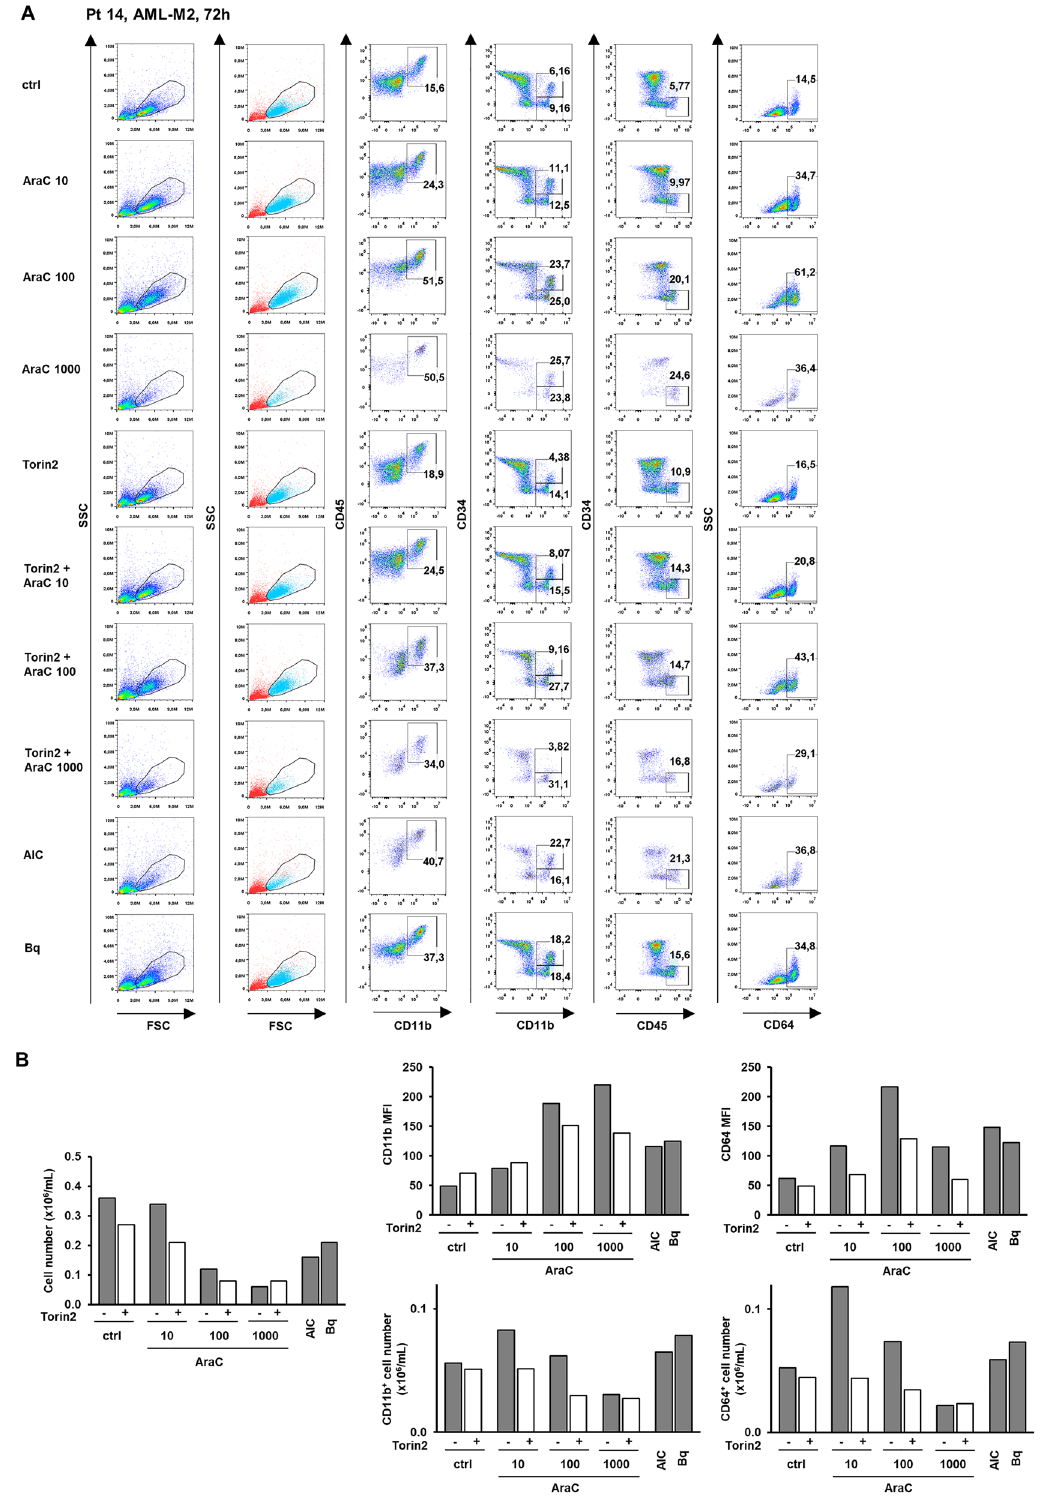
Figure 7. Cytarabine dose-dependently increases expression of differentiation markers in a primary sample from AML-M2 patient that was responsive to pyrimidine synthesis inhibition. Non-adherent mononuclear cells from bone marrow sample (Pt 14, normal karyotype, FLT3 wt, NPM wt) were plated at concentration 0.4 × 10 6 /mL in medium supplemented with 50 ng/mL IL-3, IL-6, SCF and FLT3L and incubated with AraC (10, 100, 1000 nM) with or without Torin2 (10 nM) for 72 h. AICAr (AIC) (0.2 mM) and brequinar (Bq) (0.5 µM) were used as positive controls. (A) Flow cytometric analysis of CD11b + CD45 + , CD11b + CD34 + and CD11b + CD34 - , CD45 high CD34 - , and CD64 + populations. Percentage of cells in population of interest is indicated in respective gates. Cells within the gate that stained negative for 7-AAD are shown in blue. (B) The number of viable cells was determined by trypan blue exclusion. Mean fluorescence intensity (MFI) of CD11b and CD64 was calculated as described under “Methods” section. Absolute number of CD11b + and CD64 + cells was calculated from the number of viable cells and the percentage of CD11b + CD45 + and CD64 + cells,